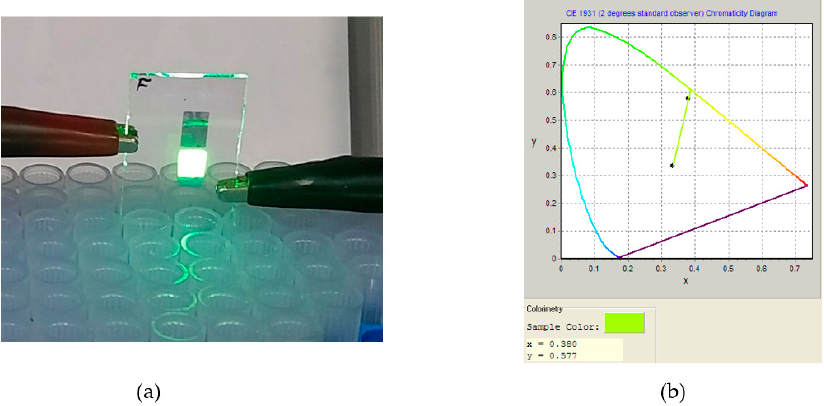
Figure 4. ( a ) OLED based on EML with the D3 (10 wt %)/mCP composite; ( b ) the CIE chromaticity diagram recorded at 8V. Table 3. EL characteristics of the studied OLEDs with different light-emitting layers